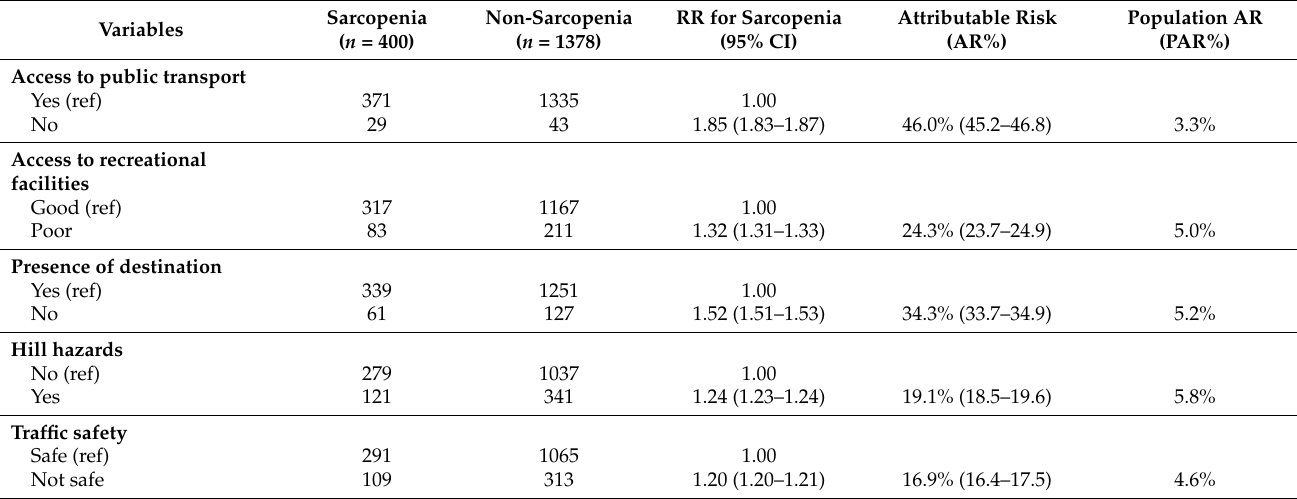
Table A2. Attributable risk (AR) and population attributable risk (PAR) of neighborhood environmental five factors for sarcopenia ( n =